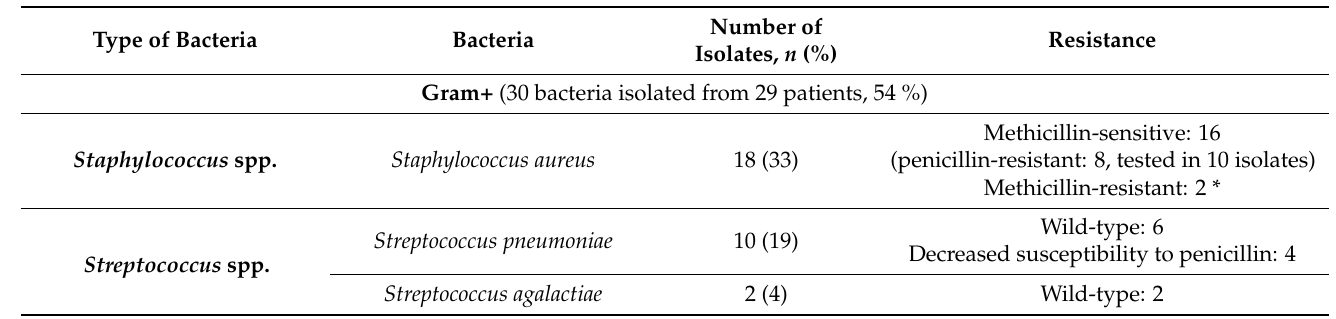
Bacterial strains identified by endotracheal aspirate in patients with bacterial aspiration